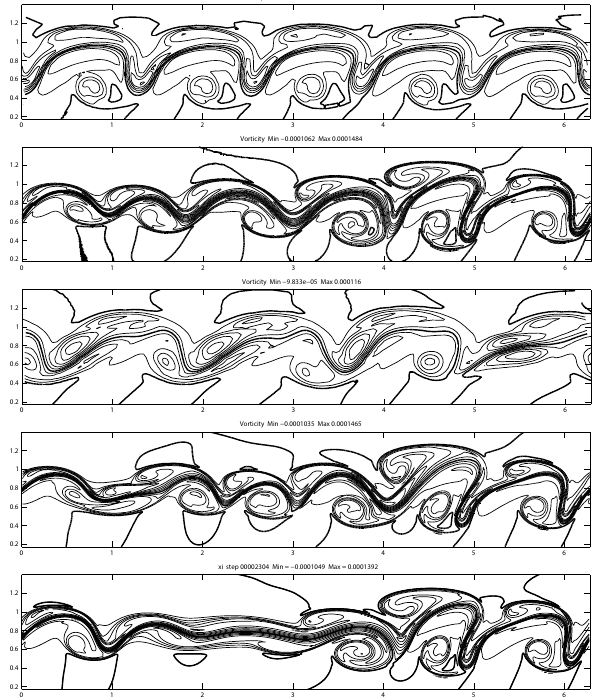
Figure 9. Vorticity field at day 6 for the barotropic instability test case. Row 1: hexagonal grid, 10242 cells. Row 2: hexagonal grid, 163842 cells. Row 3: cubed-sphere grid, 13824 cells. Row 4: cubed-sphere grid 221184 cells. Row 5: ENDGame 640 × 320 cells The plotted domain is 0 ◦ to 360 ◦ longitude, 10 ◦ to 80 ◦ latitude. Contour interval 2 × 10 − 5 s − 1